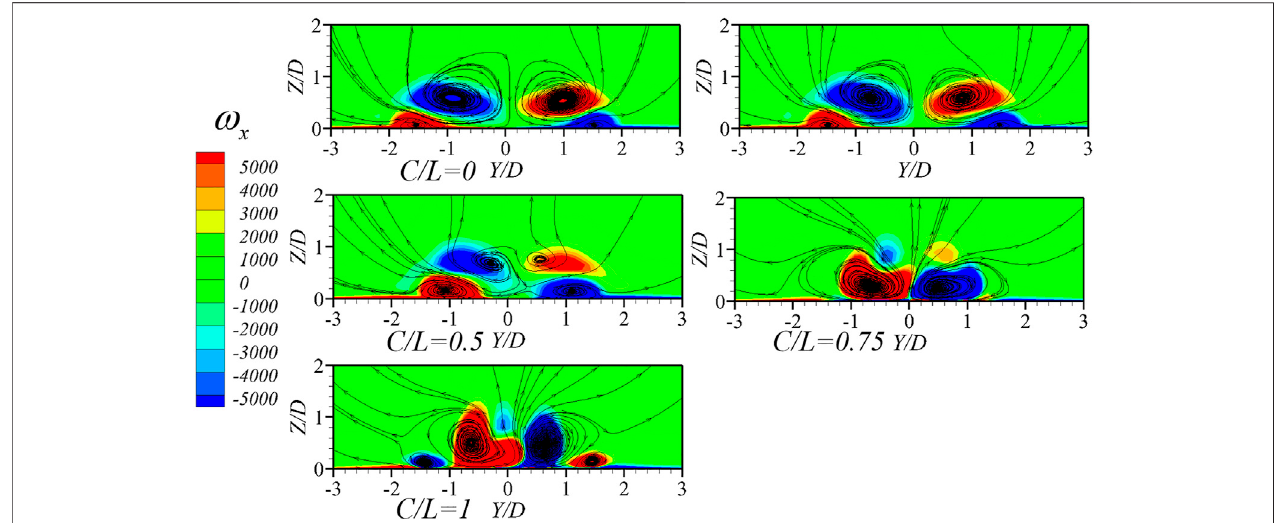
FIGURE 15 | X-direction vorticity contour and streamline at X/D (cid:2) 2 plane in M (cid:2) 2.5 condition.